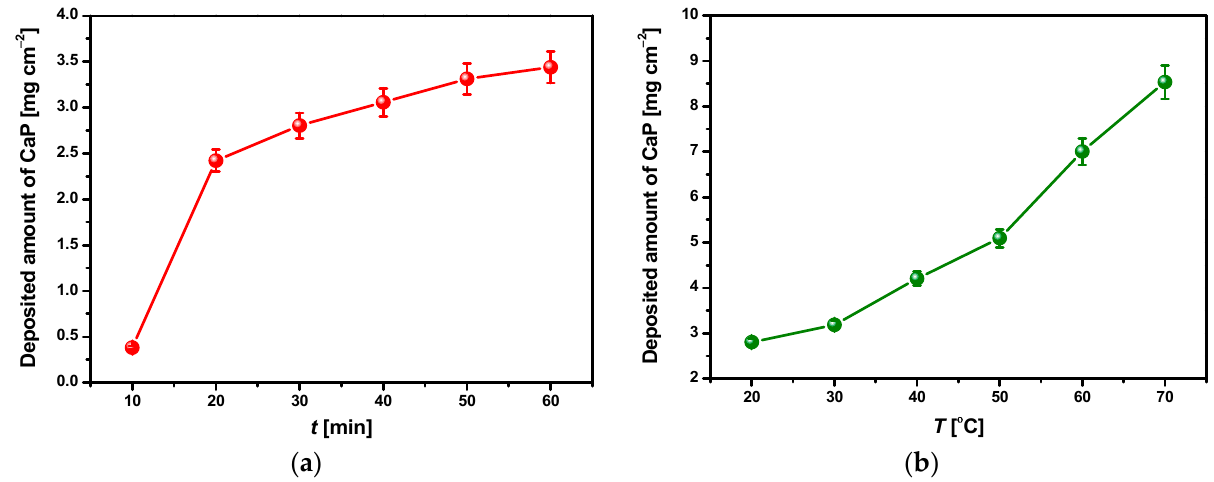
Figure 4. The deposited amount of CaP on the CpTi G4 substrate after ECAD in the acetate bath at the deposition potential of − 3 V as a function of: ( a ) Deposition time at room temperature; ( b ) Bath temperature for the deposition time of 1800 s.